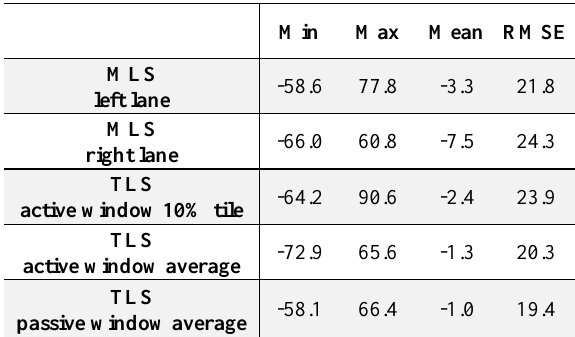
Table 1. Statistical summary of the errors in estimating retroreflectivity using TLS and MLS point clouds compared with the handheld retroreflectometer. (unit: mcd/lx/m 2 )